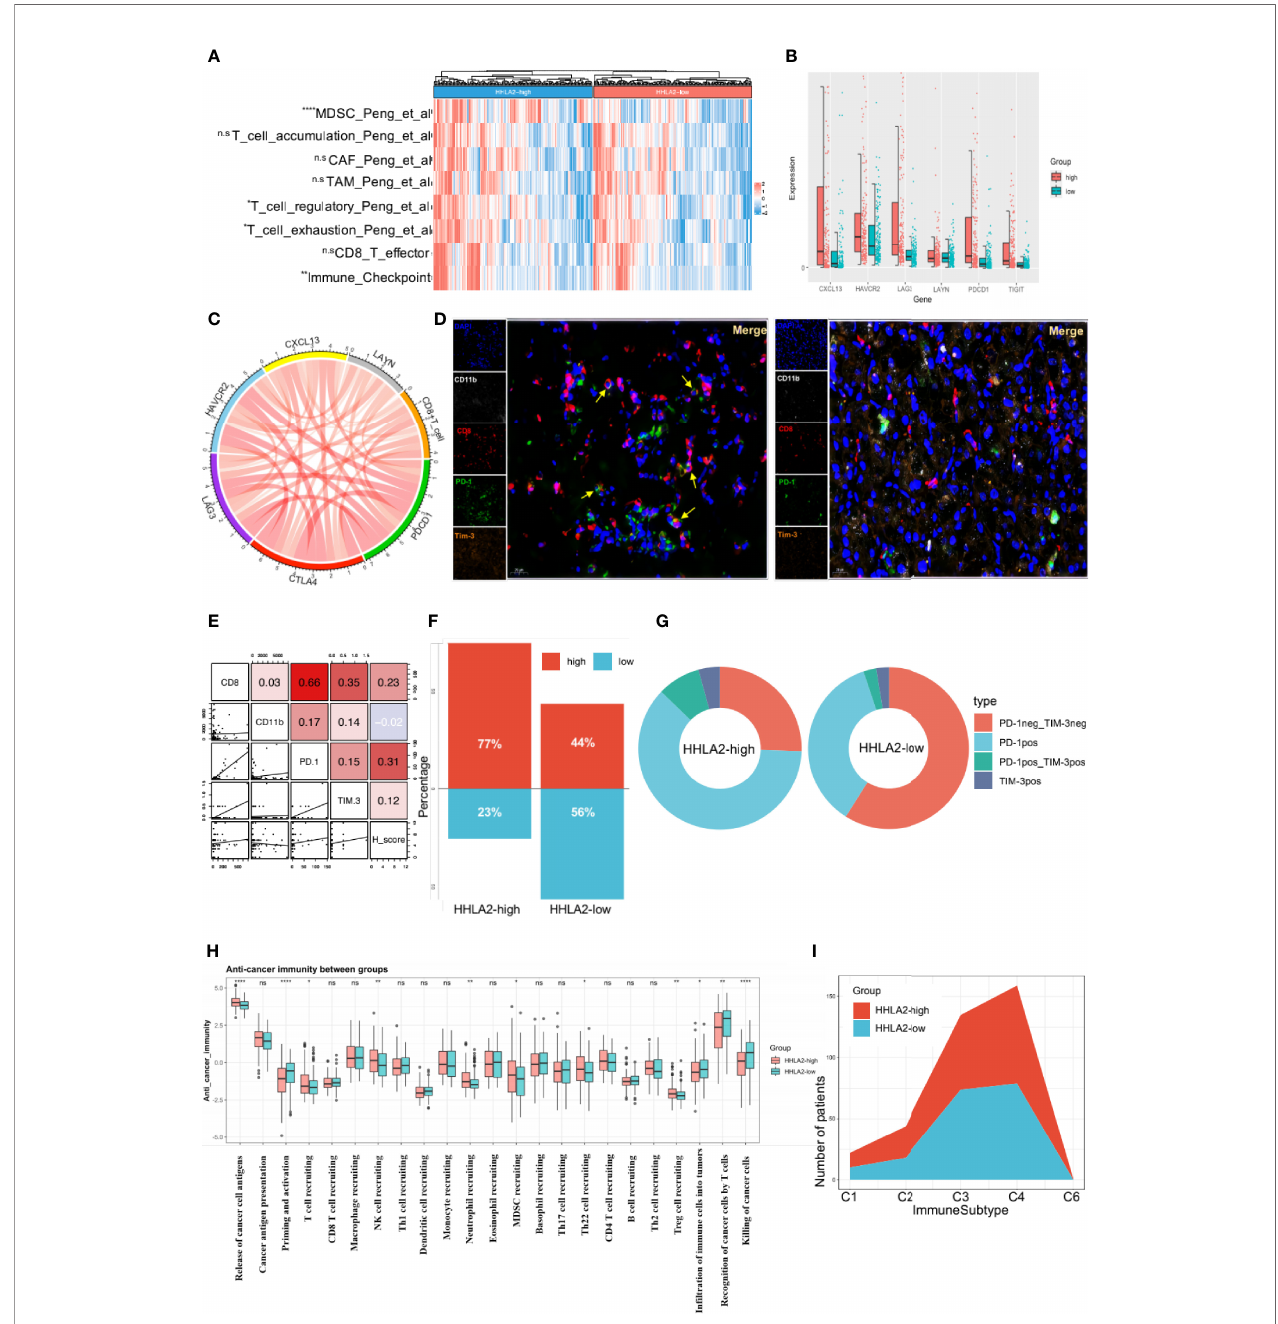
FIGURE 5 | High expression of HHLA2 shaped an immunosuppressive TIME. (A) Heatmap of comparison of immune-related pathways between subgroups. (B) Comparisons of all 6 markers of exhaustion between HHLA2-high and HHLA2-low subgroups. (C) String plot illustrating correlation between HHLA2 and exhaustion markers. (D) Representative images of multiplex immuno fl uorescence (mIF) results between subgroups. (E) Correlation matrix plot showing relation between H-score and mIF results. (F) Proportions of total exhausted T cells in HHLA2-high and HHLA2-low subgroups. (G) Comparison of the types of exhausted T cells between subgroups. (H) Differences between HHLA2 subgroups in 7 anti-cancer immunity steps. (I) Proportions of immune subtypes in different HHLA2 subgroups. *p < 0.05, **p < 0.01, ***p < 0.001, ****p < 0.0001. ns, not signi fi